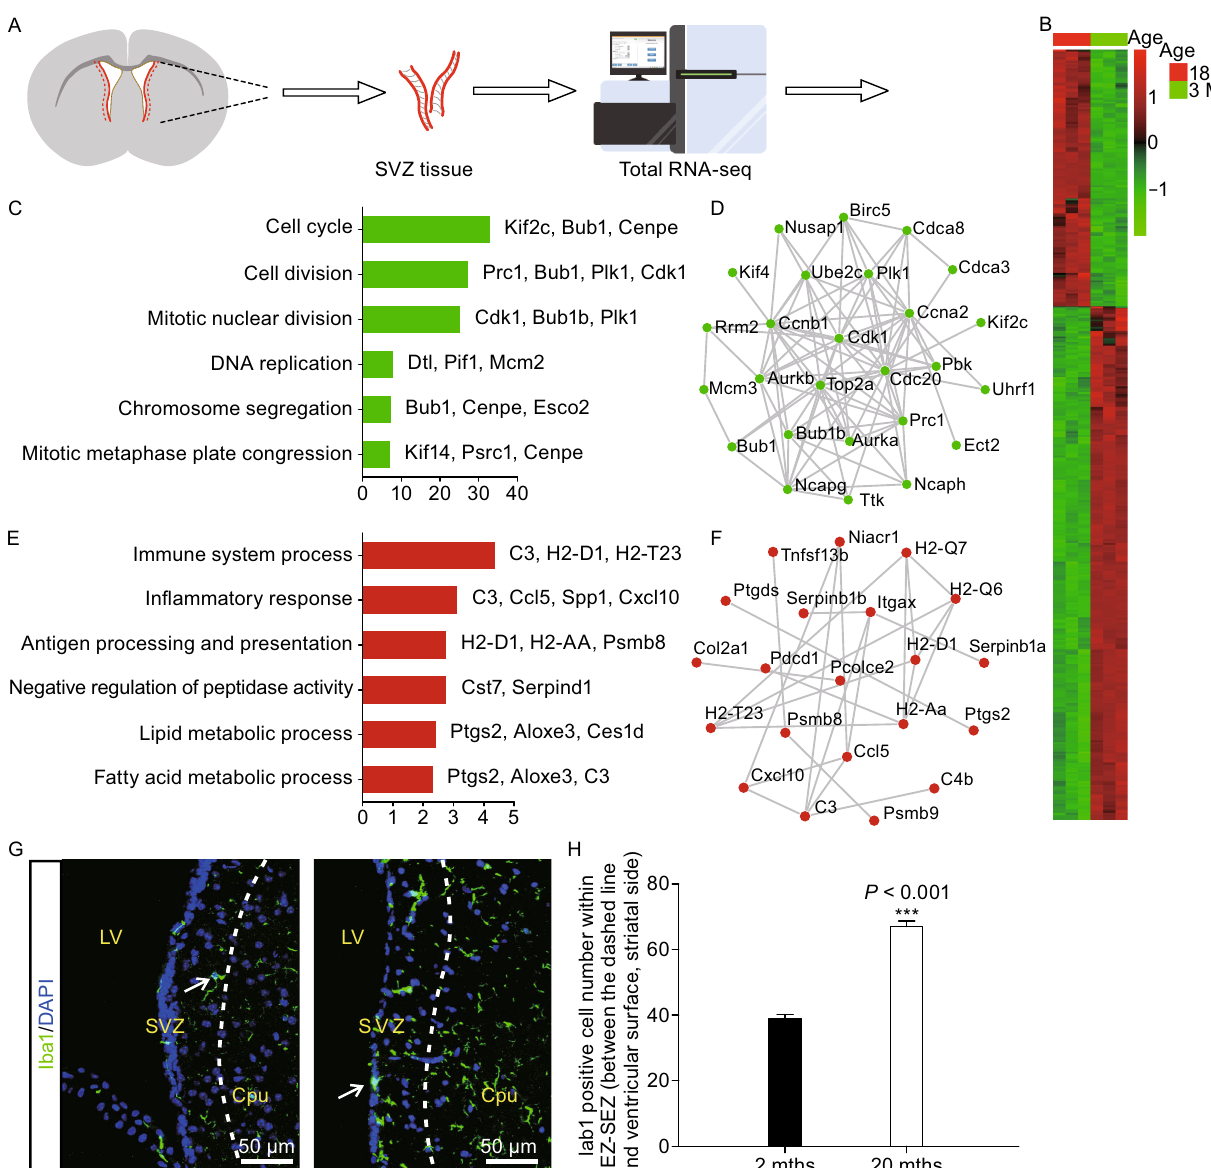
Figure 3. Total RNA-seq of brain tissue surrounding EZ-SEZ/SVZ revealed NSC/NPCs reside in a rather in fl ammatory environment in aged brain. (A) Schematic showing EZ-SEZ/SVZ tissue dissection and subsequent total RNA-seq. (B) Heatmap of differentially expressed genes in EZ-SEZ/SVZ tissue respectively derived from young (3 weeks) and old (18 mths) mice ( n = 3 per age group). (C) GO analyses and (D) STRING protein-protein interaction network of down-related genes in aged group. Length of bars indicated the signi fi cance ( − log10 transferred P -value, Fisher exact test). (E) GO analyses and (F) STRING protein-protein interaction network of up-related genes in old group. Length of bars indicated the signi fi cance ( − log10 transferred P -value, Fisher exact test). (G) Representative micrograph of sagittal sections from young (2 mths) and old (20 mths) mouse SEZ/SVZ region immune-stained with Iba1 (green). (H) Quanti fi cation of Iba1 positive cells in young (2 mths, n ≥ 3) and old (20 mths, n ≥ 3) mouse SEZ/SVZ region. Error bars indicate the SEM from at least three independent experiments. *** P < 0.001. Cpu, caudate putamen; LV, lateral